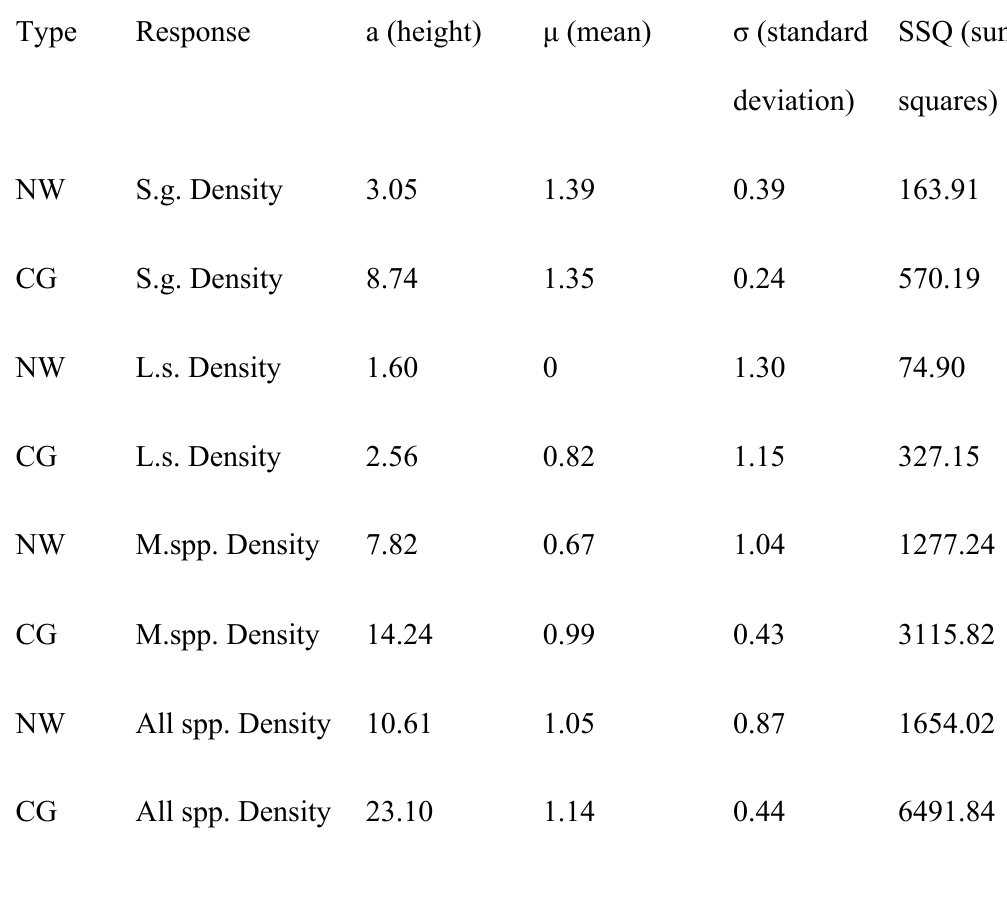
Table A2.1. Parameters for the modeled response of density (count/0.0156m 3 ) of butter clam ( Saxidomus gigantea ), Bentnose macoma ( Macoma spp. ), littleneck clam ( Leukoma staminea ) and total clam species as a function of intertidal height. Each response was predicted by fitting a Gaussian curve (Eq. A4.1) to the